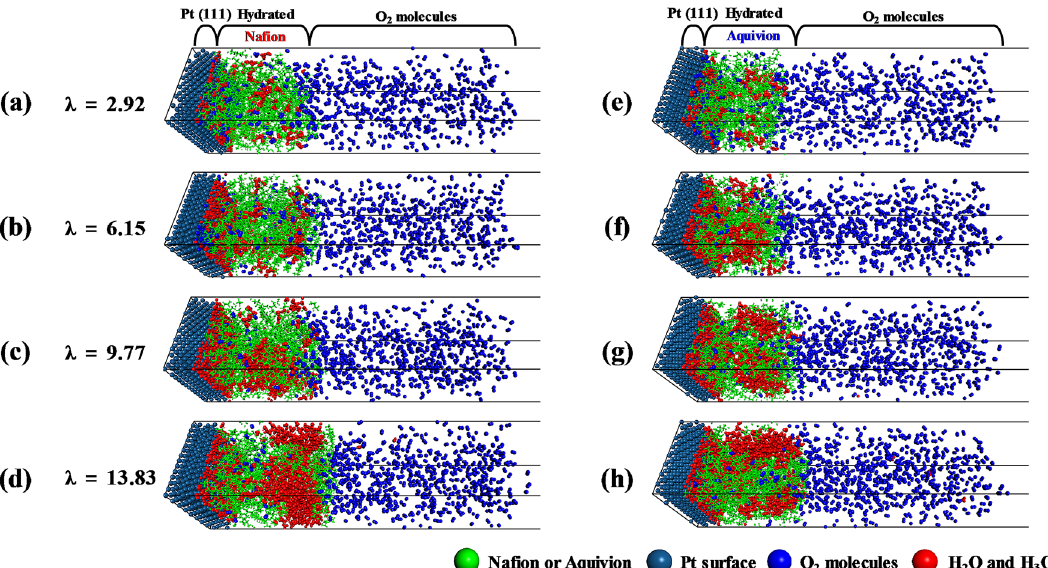
Figure 3. Snapshots of equilibrated systems comprising the Pt (111) surface, hydrated Nafion ionomers, and O 2 molecules with λ values of ( a ) 2.92, ( b ) 6.15, ( c ) 9.77, and ( d ) 13.83; snapshots of equilibrated systems comprising the Pt (111) surface, hydrated Aquivion ionomers, and O 2 molecules with λ values of ( e ) 2.92, ( f ) 6.15, ( g ) 9.77, and ( h )